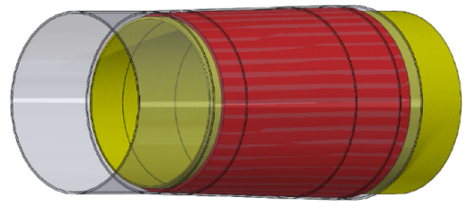
Figure 4. Submodel of the grout connection.